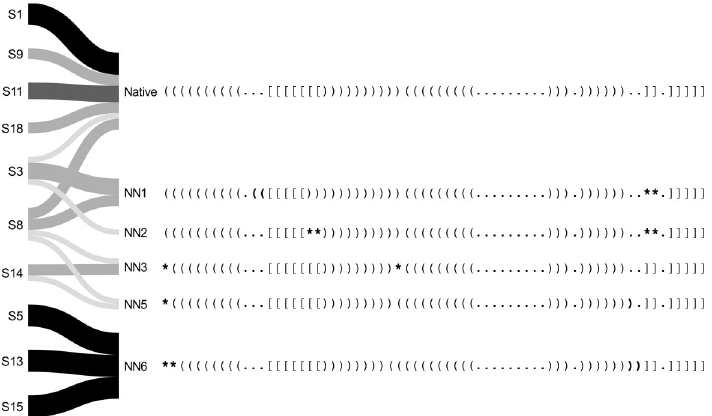
Fig 6. Shapify predicted native-adjacent structural paths. Presentation of structural paths from each initial stem leading to native or non-native (but native-adjacent) secondary structures (e.g., NN1 is the lowest free energy non- native structure; cf. Table O in S1 File). Initial stems labeled on the left (e.g., S1 for initial stem 1; cf. Table 4). If the structure predicted for a specific initial stem was the same for all four SHAPE datasets it is presented with a black colored path. In other cases, where the predicted structure was the same for three, two, or only one of the SHAPE datasets, the path is colored dark grey, grey, or light grey, respectively. Differences from the native structure are marked in bold, with parentheses/brackets representing changes in paired bases, and asterisks representing predicted unpaired bases that were paired in the native structure.